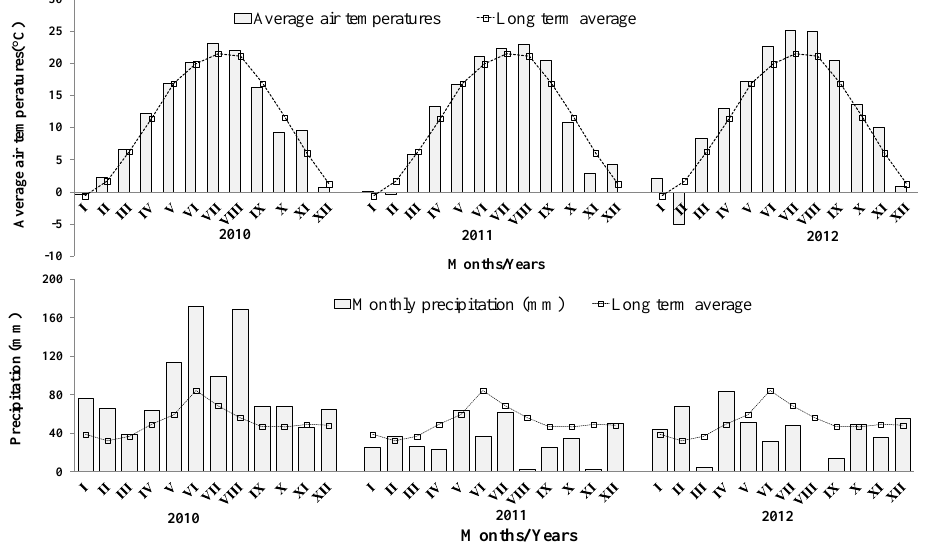
Figure 1. Average air temperature and total monthly precipitation for hydrological years (2010 – 2012).